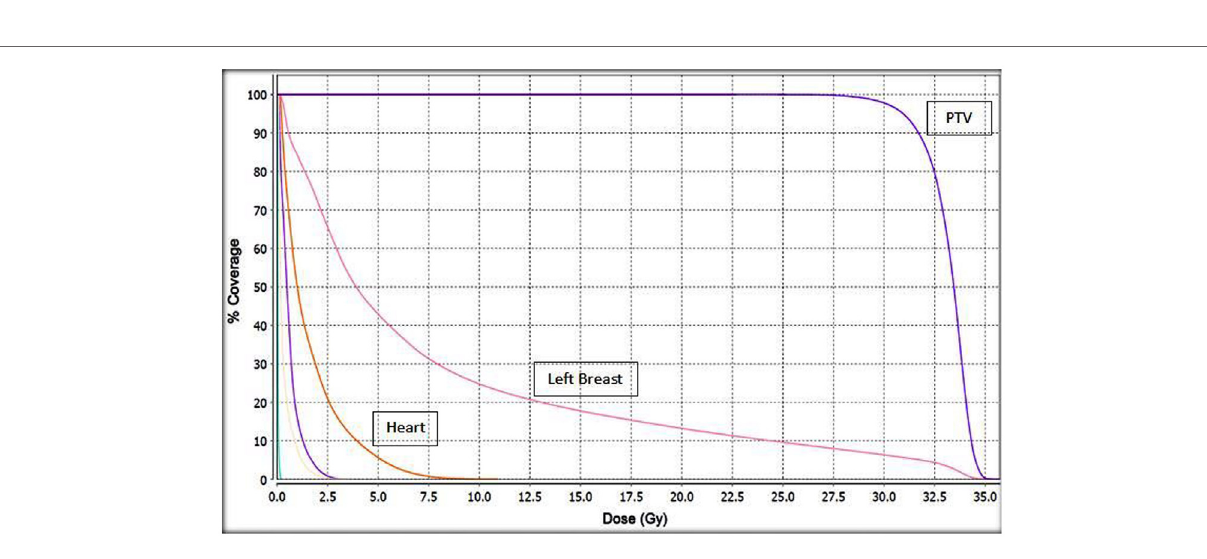
FigUre 2 | cumulative dose volume histogram (DVh) for the target PTV and normal tissues . This plan was normalized to deliver 30 Gy to the PTV. Unlabeled structures: left lung; purple. Right lung; yellow. Right breast; light blue.